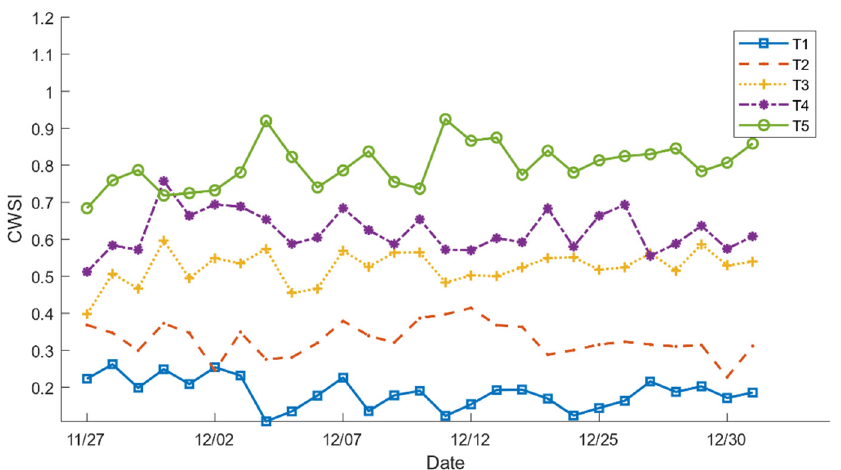
Figure 7. Daily CWSI for the five water stress treatments (T1–T5).